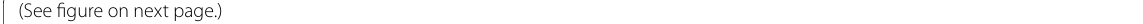
Fig. 4 hGC33-null-NP and hGC33-induced cell cycle arrest in G1 phase and inhibited cyclinD1 expression in HepG2 cells. a Representative cell– cycle diagram of various groups treated with hGC33-null-NP and hGC33. b Cell cycle analysis of various groups treated with hGC33-null-NP and hGC33. The HCC cells were incubated with 0.5 μm hGC33 or hGC33-null-NP (with the molar concentration of hGC33 as reference). * P < 0.05, the G1 phase of hGC33-null-NP or hGC33 cells was compared with that of 0 h cells. c , d After hGC33-null-NP or hGC33 treatment, cyclinD1 was significantly down regulated in HepG2 cells compared with that in the control